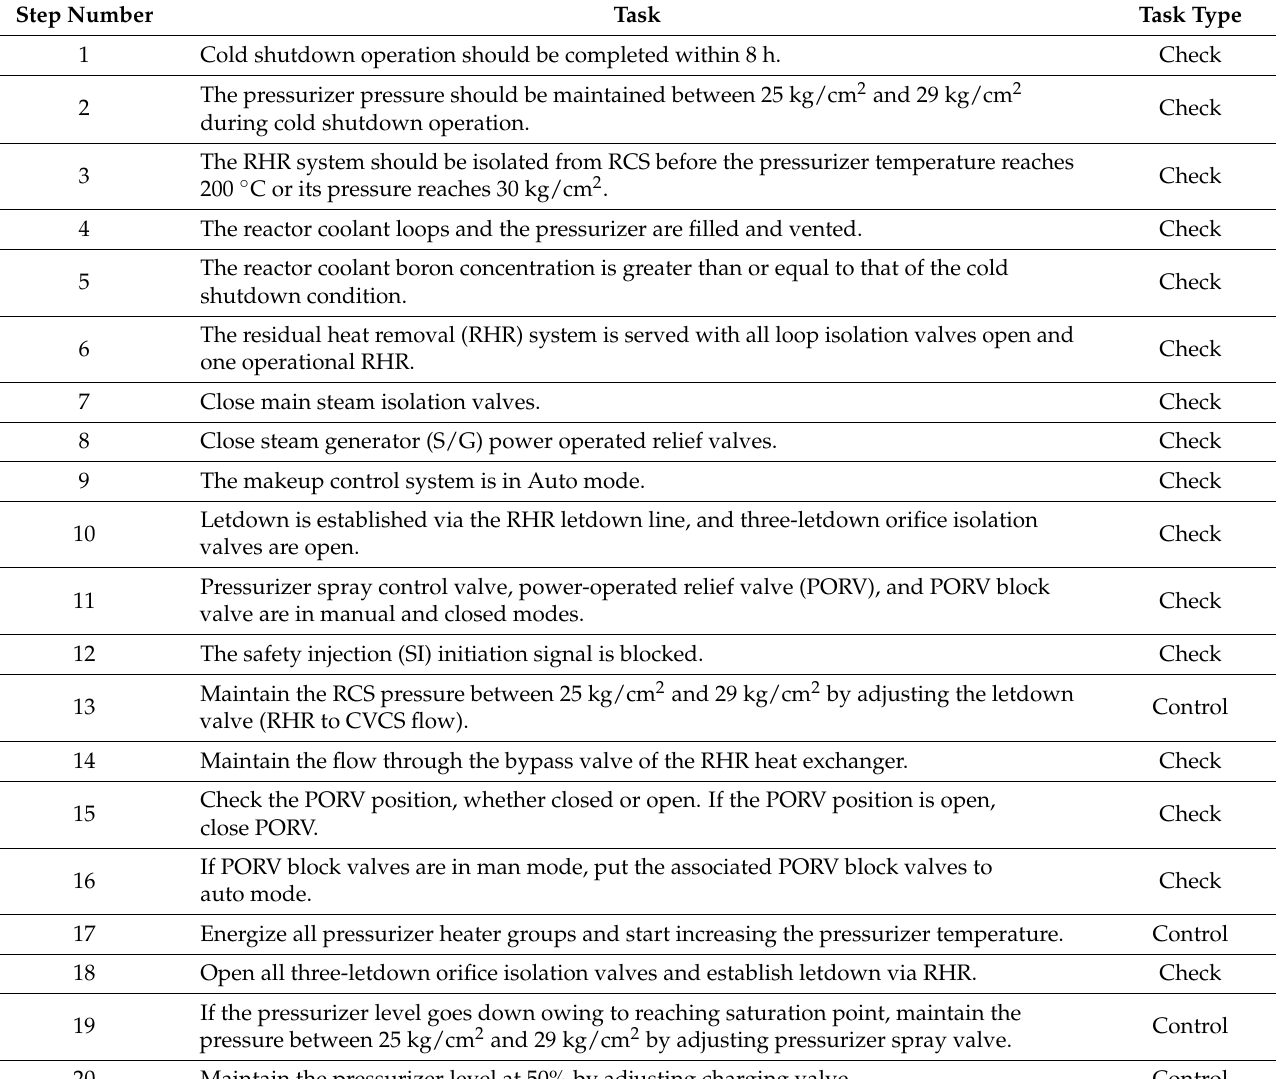
Table 2. Task analysis result for cold shutdown